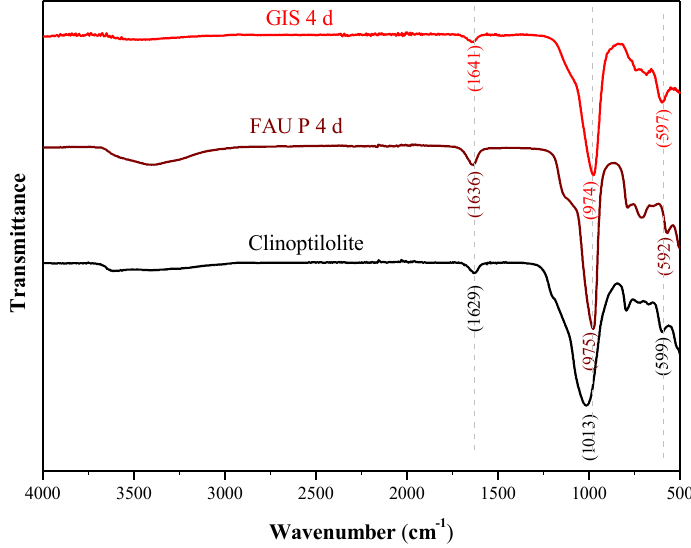
Figure 4. FTIR spectra of clinoptilolite, FAUP4d and GISC4d samples. The band at ~1630–1640 cm − 1 is attributed to the bending vibration of OH groups in the adsorbed water and occurs for all materials. The band near 1000 cm − 1 refers to an internal tetrahedral group insensible to structure. The bands in the region of 450 to 1000 cm − 1 refer to the zeolite structure [40]. It was possible to observe some changes in these bands for the GIS4d and FAUP4d samples compared to the spectrum of clinoptilolite. Scanning electron microscopy (SEM) images of clinoptilolite and GIS 4 d samples are